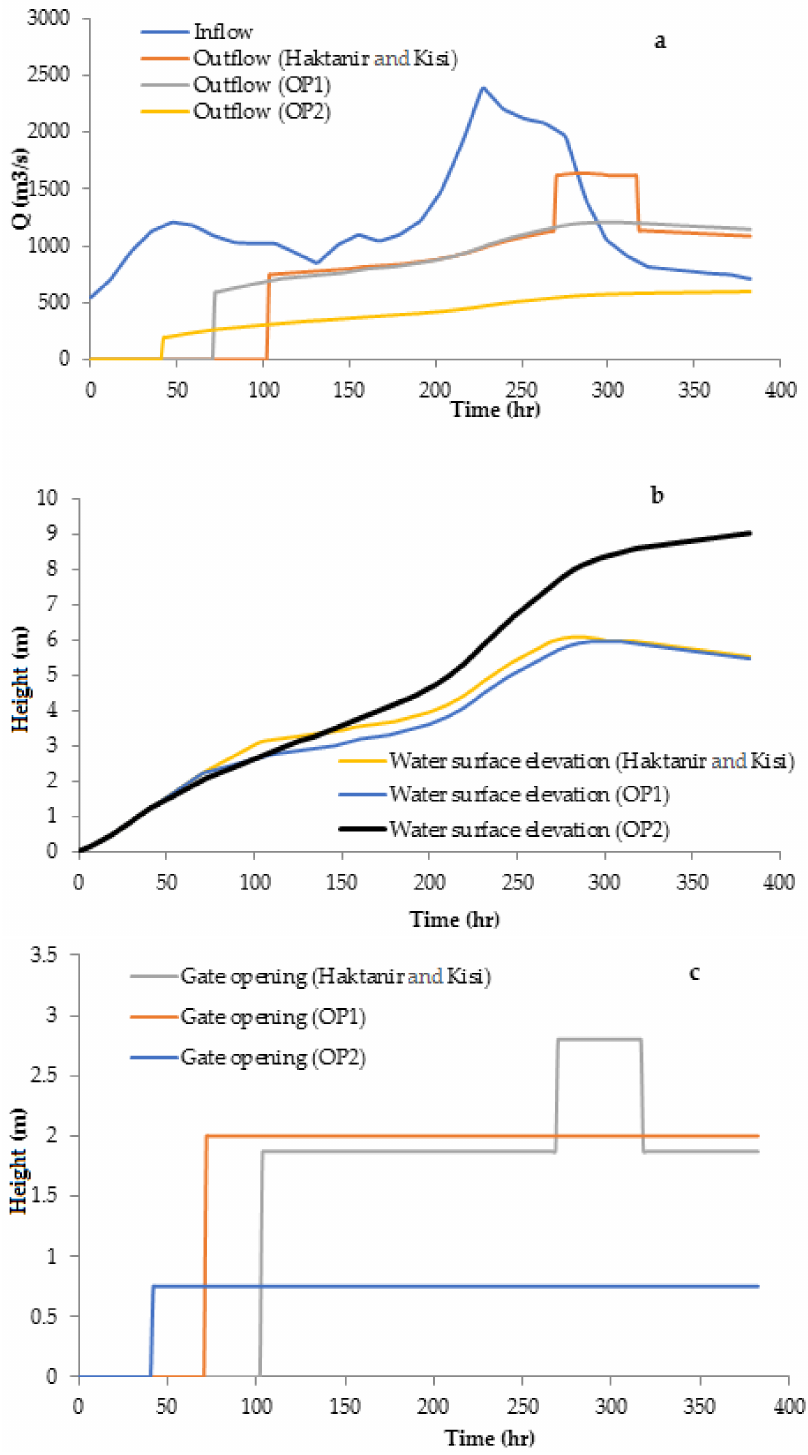
Figure 4. Application of both approaches—flood hydrograph (10-year): ( a ) inflow and outflow hydrographs; ( b ) water surface elevation; ( c ) gate opening ( n =